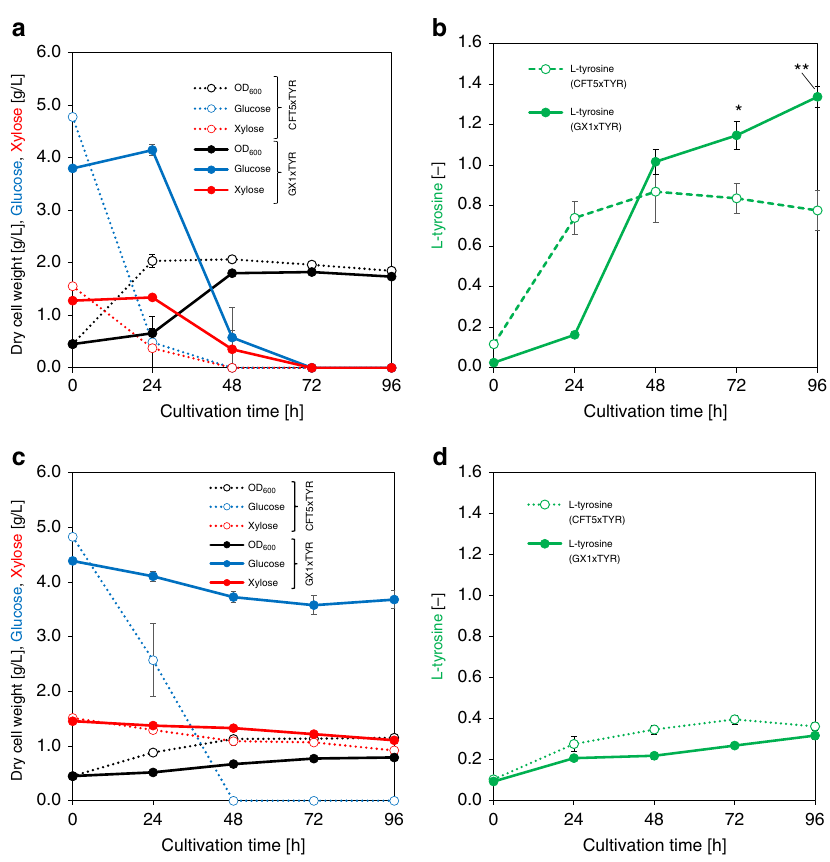
Fig. 8 Cultures pro fi les of L -tyrosine-producing strains. a , b Aerobic condition. c , d Micro-aerobic condition. a , c Black, blue, and red symbols indicate bacterial cell growth, glucose consumption, and xylose consumption, respectively. b , d Green symbols indicate the produced amounts of L -tyrosine. All open symbols and fi lled symbols indicate the results for the CFT5xTYR and GX1xTYR strains, respectively. The data are presented as the average of three independent experiments, and error bars indicate standard errors. P values were computed using the two-tailed Student ’ s t -test (* P < 0.05; ** P < 0.01). Source data are provided as a Source Data fi